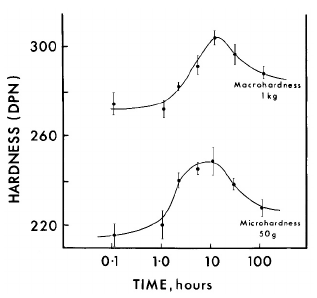
Figure 7. Variation in diamond pyramid hardness (1 kg and 50 g) with ordering time at 650 °C for Fe-24.5 at. % Pt alloy [51]. (Used with permission of The Minerals, Metals & Materials Society).